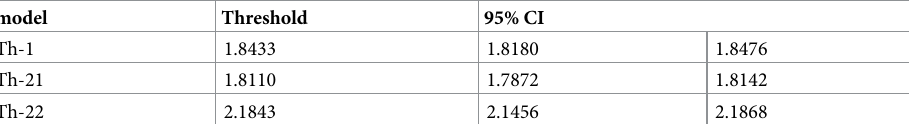
Table 8. Threshold estimation results.